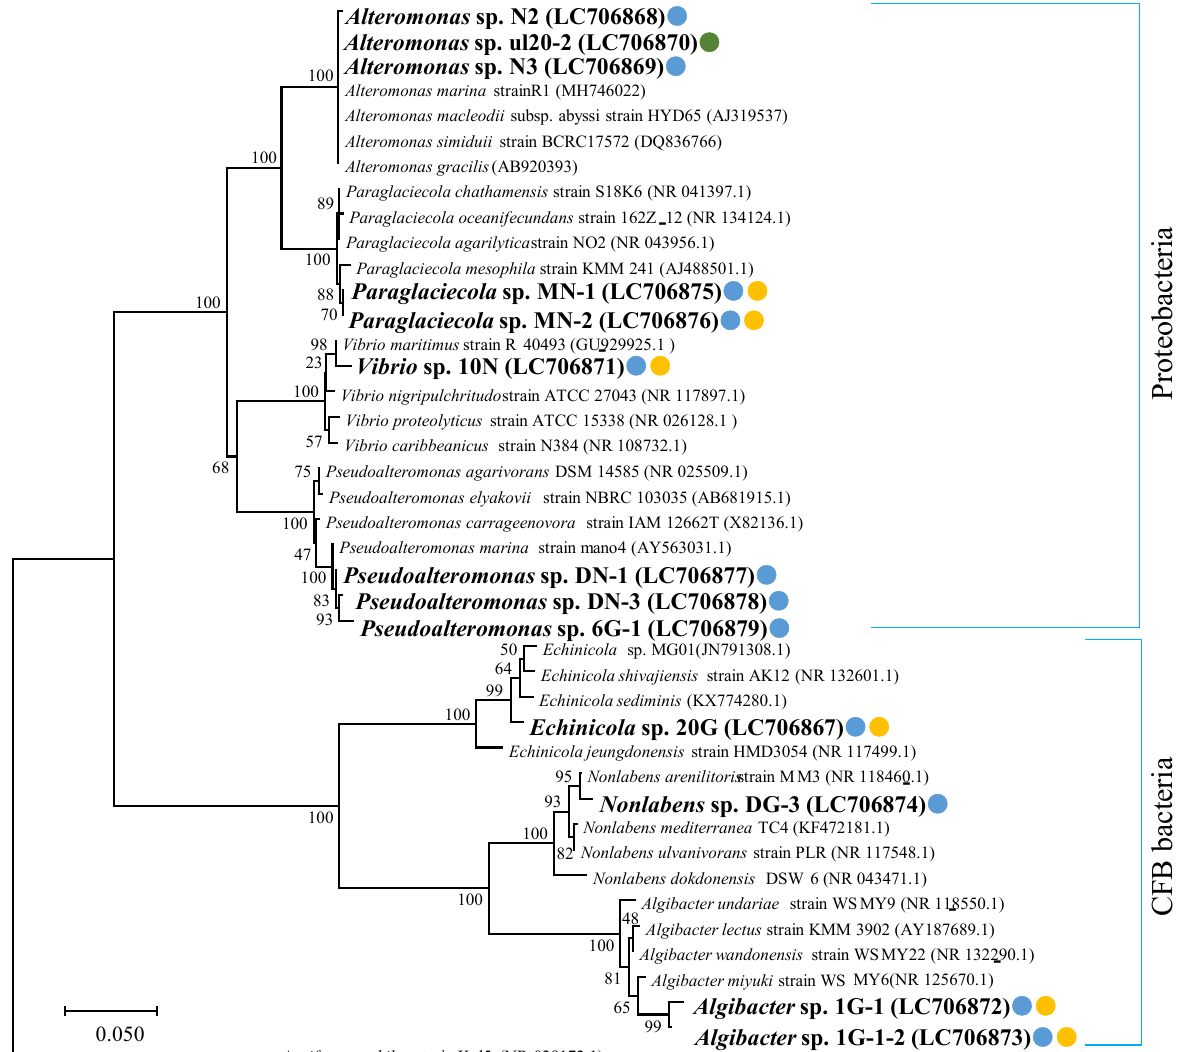
Figure 2. Maximum parsimony tree based on 16S rRNA gene sequences showing the relationship between ulvan-degrading bacteria and other bacteria. Bootstrap values (%) based on 1000 replications are shown at tree nodes. The sequence from this study is shown in bold text. Isolates from ulva are indicated by green circle. Isolates from seawater are indicated by blue circles. Novel ulvan-degrading bacteria are indicated by yellow circles.